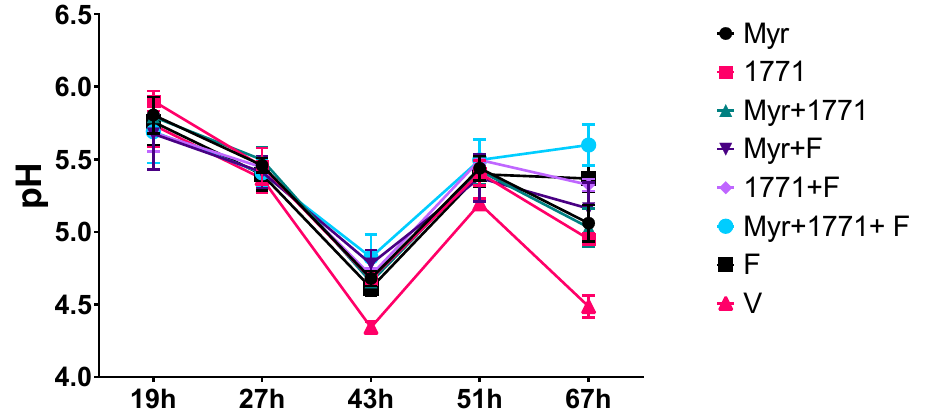
Figure 4. pH of spent culture media from topically treated biofilms at distinct developmental phases. The spent biofilm culture media were evaluated at 19, 27, 43, 51, and 67 h. At 19 h, the culture medium of biofilms treated with compound 1771 showed a higher pH value when compared to Myr + F ( p = 0.0009), 1771 + F ( p = 0.0017), Myr + 1771 + F ( p = 0.0027), and V ( p = 0.0466) (one-way ANOVA, followed by Tukey’s test). At 27 h, there was no significant difference between treatments. The culture medium from vehicle-treated biofilms showed lower pH at 43, 51, and 67 h compared to all treatments ( p < 0.0001; one-way ANOVA, followed by Tukey’s test). The medium from Myr + 1771 + F had the highest pH value when compared to Myr + 1771 and F at 43 h, and at presented the highest pH value at 67 h ( p < 0.05, one-way ANOVA, followed by Tukey’s test). The data represented are the means, and the error bars correspond to the standard deviation.